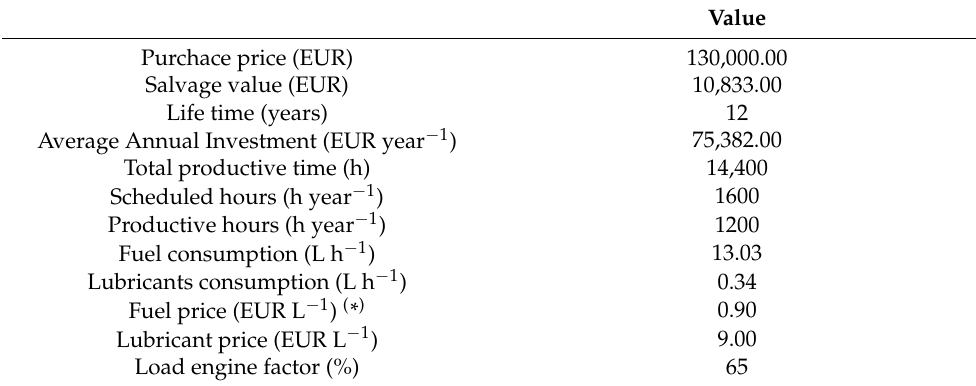
Table 1. Main economic elements considered to calculate the hourly cost of the